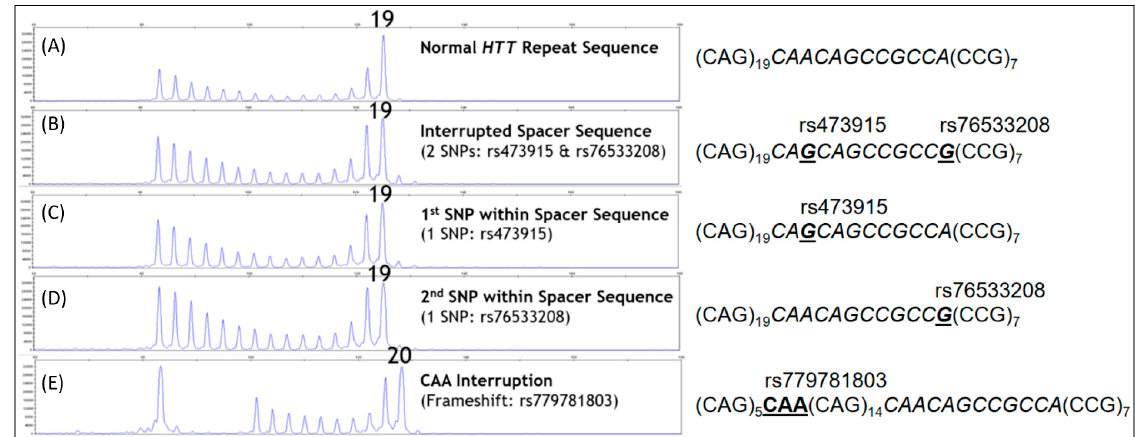
Figure 3. Known polymorphisms adjacent to or within the CAG repeat tract. The AmplideX PCR/CE HTT Kit accurately genotypes templates with known polymorphisms adjacent to or within the CAG repeat tract. ( A ) Template with 19 repeats showing the expected CE electropherogram and corresponding genotype for the relevant portion of the HTT reference sequence. ( B ) DNA with two SNPs (rs473915 A>G and rs76533208 A>G) interrupting the 12-bp spacer region (shown in italics) is successfully amplified to produce the expected 19 CAG result. ( C , D ) PCR/CE genotyping of each SNP (rs473915 or rs76533208, respectively) results in the correct 19 CAG call. ( E ) A CAA frameshift (rs779781803) within the repeat sequence shows a repeat-primed amplification pattern and a terminal peak corresponding to 20 CAG, rather than 19 CAG, due to the mobility shift caused by the triplet interruption. Note that the CAA interruption causes a signal “dip” in the repeat-primed pattern; this dip flags result as suspicious for unexpected sequence variation.